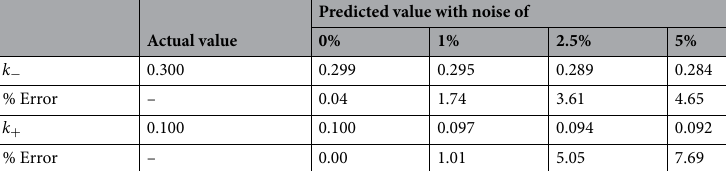
Table 4. RhINNs predicted values for k + and k − in a start-up of a flow with shear rate of ˙ γ = 0.1 [ 1 / s ] with noisy data. For all cases G = 800 [ Pa ] , σ y = 20 [ Pa ] , η s = 20 [ Pa s ] , and η p = 20 [ Pa s ] are known from the material